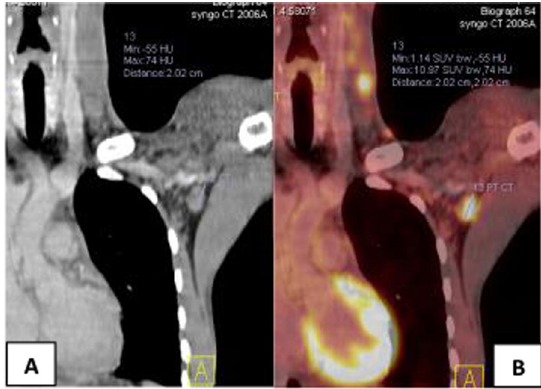
Fig. 3 A 42-year-old male patient with NHL, treated with anti-cd20 antibody rituximab 10 months prior to vaccination. After 1 year of disease-free, PET/CT reported new left axillary, supraclavicular and lower cervical LNs. Clinical data revealed that he received the 2nd dose of Pfizer-BioNTech vaccine in his left arm 6 days prior to PET/ CT. A Coronal CECT and B coronal PET/CT images revealed enlarged FDG-avid left axillary, supraclavicular and lower cervical LNs, largest measures 2 cm in left axilla of 11